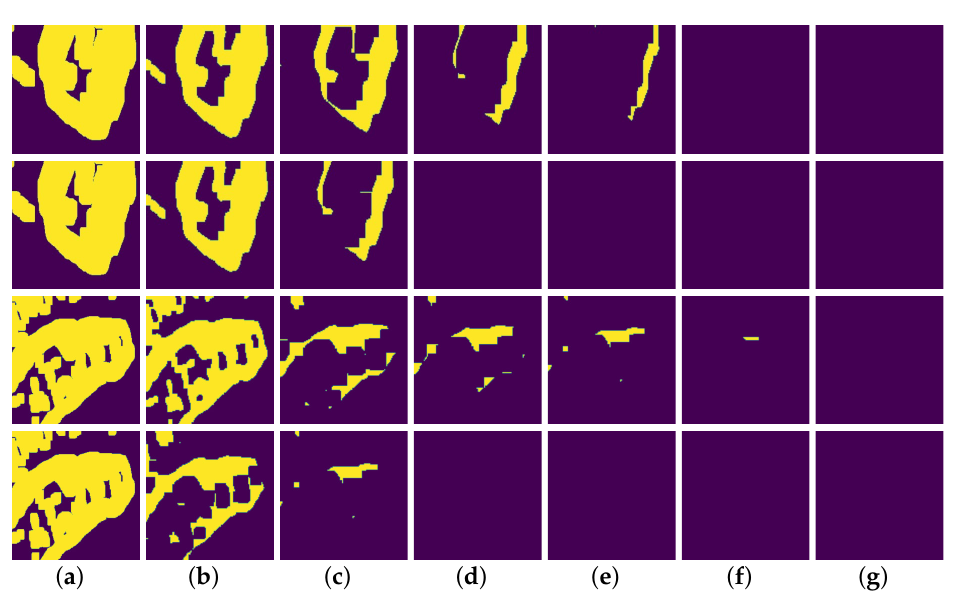
Figure 8. Visualization of the mask updated during the inpainting process. Yellow areas represent invalid pixels, and purple areas denote valid pixels. From the left to the right are: ( a ) Input mask, ( b ) first updated mask, ( c ) second updated mask, ( d ) third updated mask, ( e ) fourth updated mask, ( f ) fifth updated mask, ( g ) sixth updated